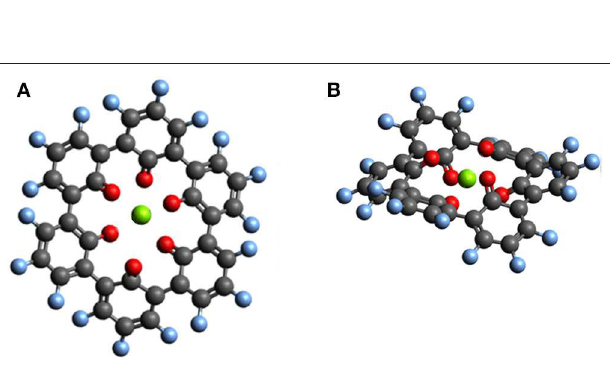
FIGURE 9 | Top view (A) and side view (B) of the optimized structure of hypothetical C 36 F 18 MgO 6 molecule for which a voltage of 3.51V vs. Mg 2 + /Mg was